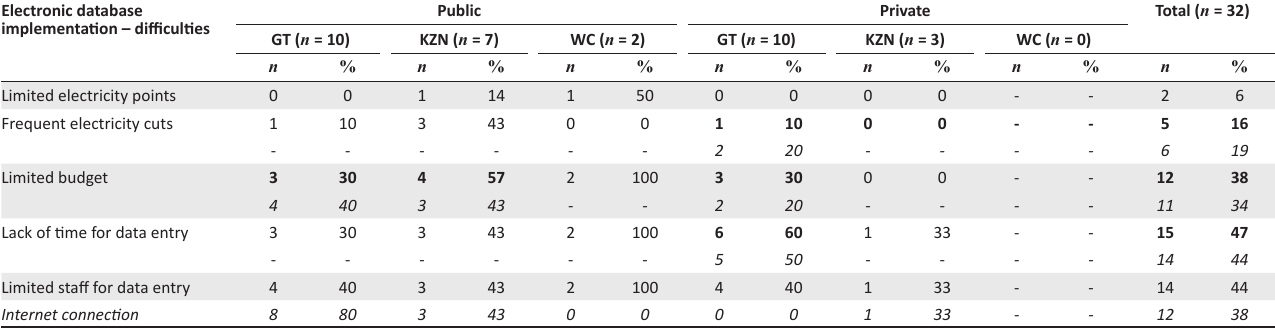
TABLE 2: Difficulties implementing an online or electronic database